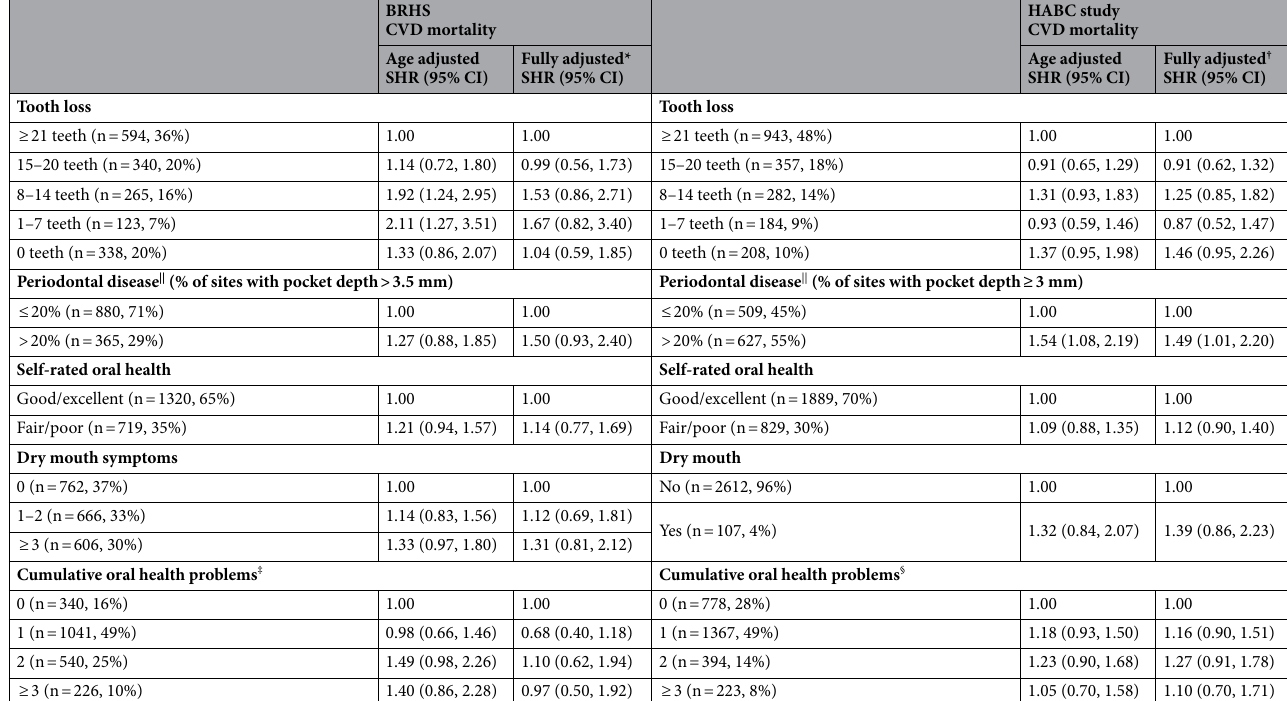
Table 3. Competing risk analysis (subdistribution hazard ratios (SHR) and 95% confidence intervals (CI)) for the association between oral health problems and risk of CVD mortality in older people in the BRHS after 9 years of follow-up and in the HABC Study after 15 years of follow-up. *Age, social class, smoking, alcohol, physical activity, history of CVD and diabetes, BMI, EDI score, hypertension, triglycerides, HDL, CRP, IL-6, fibrin d-dimer, hsTnT. † Age, gender, race, education, smoking, alcohol, physical activity, history of CVD and diabetes, BMI, HEI score, hypertension, total blood cholesterol, CRP, IL-6. ‡ Includes < 21 teeth, difficulty eating, symptoms of dry mouth, and sensitivity to hot/cold/sweet. § Includes < 21 teeth, difficulty eating, dry mouth when eating, and limit of food due to gum problems. || Only measures of periodontal disease with positive associations